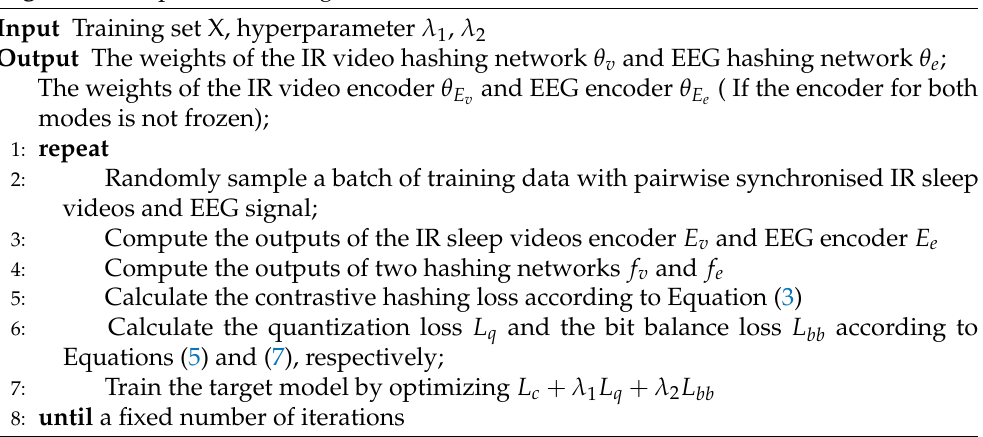
Algorithm 1 Optimization